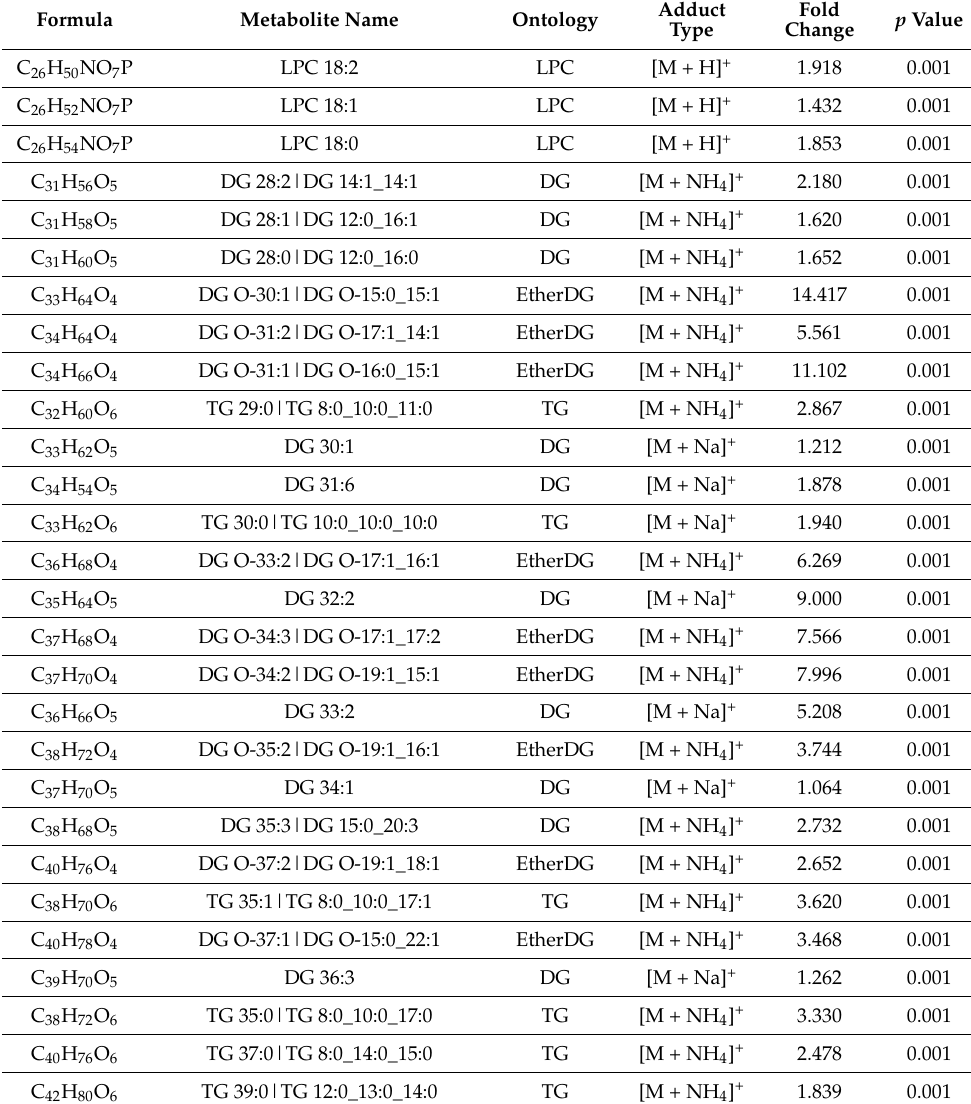
Table 2. Cutaneous lipids differentially changed after 1 month of Water